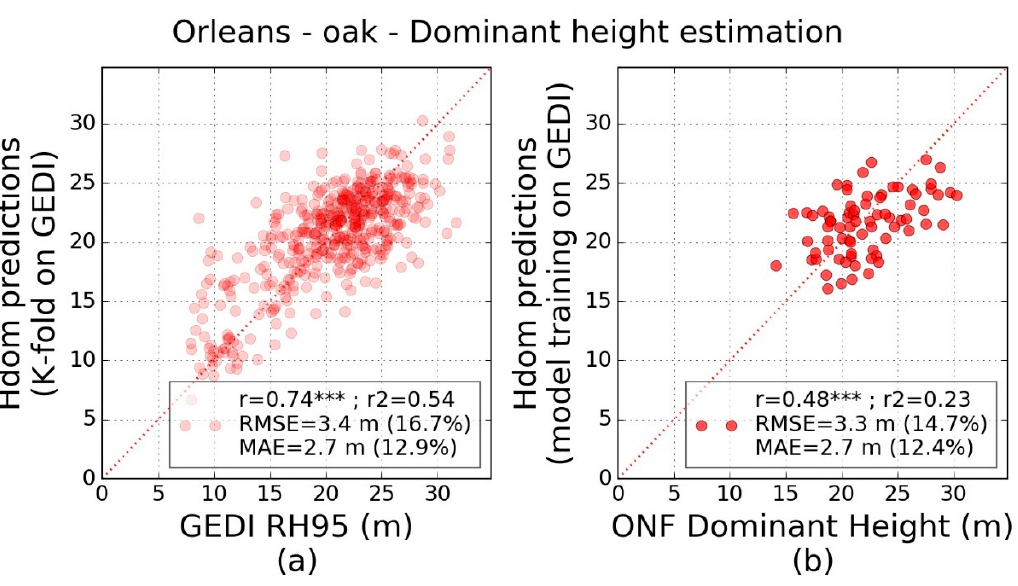
Figure 8. Oak samples (Orléans). Validation scatterplots of dominant height estimation using GEDI RH95% metric for the training model (479 samples). ( a ) GEDI’s K-fold cross-validation; ( b ) application of GEDI model on ONF measurement plots (75 samples). Statistical signicicance: *** p ≤ 0.001.